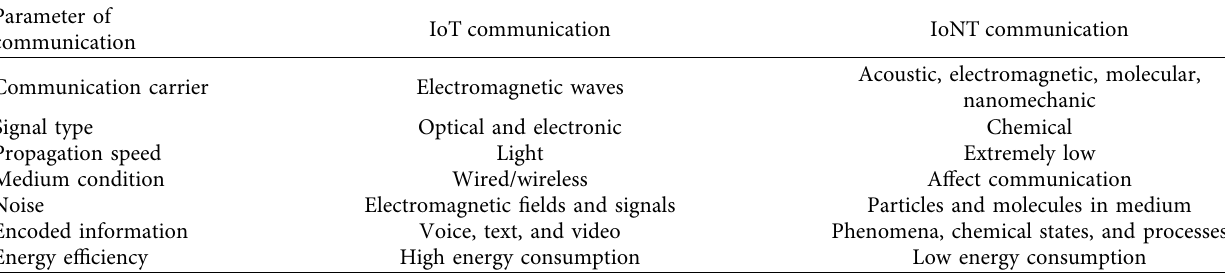
Table 1: Comparison between IoT and IoNT communications.